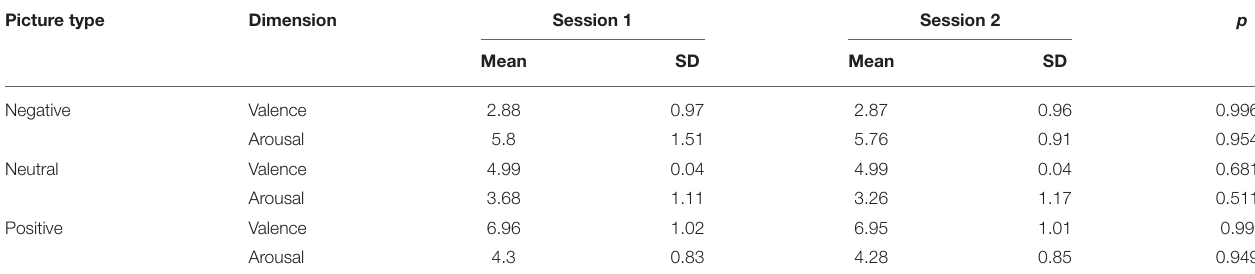
TABLE 1 | Pictures for emotion